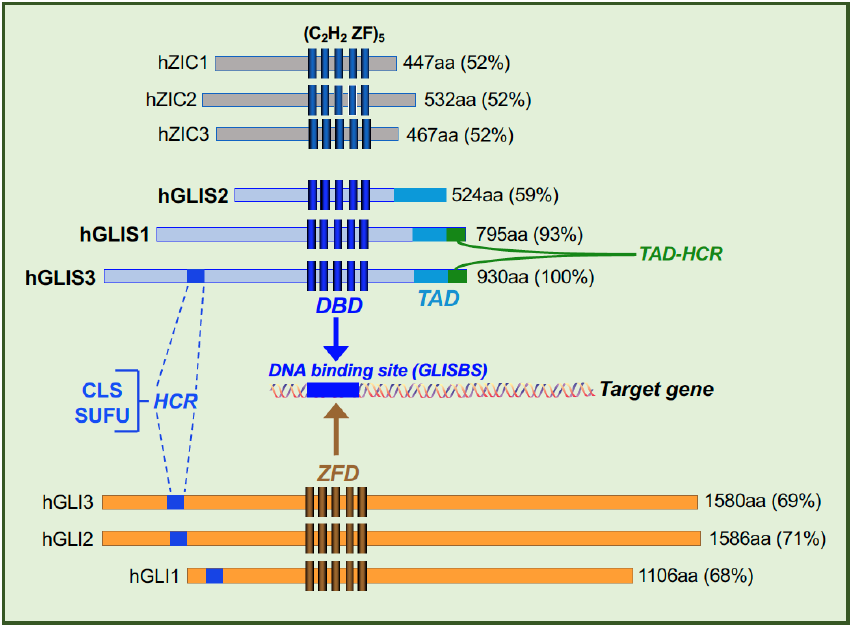
Figure 1. GLIS1-3 proteins are most closely related to members of the GLI subfamily Krüppel-like zinc finger transcription factors. The DNA binding domain (DBD) consists of five C 2 H 2 zinc fingers that exhibit high similarity with those of GLI1-3 and several ZIC family members. The DBD recognizes a GC-rich GLIS binding site (GLISBS) in regulatory region of target genes. Shown in parenthesis is the percent homology of each DBD relative to GLIS3-DBD. The transactivation domain (TAD) at the C-terminus of GLIS1 and GLIS3 contains a 32 amino acids sequence that is highly conserved (TAD-CR). The N-terminus of GLIS3 and GLI1-3 share a highly conserved region (HCR) of about 60 amino acids that contains a SUFU binding site and a ciliary localization signal (CLS) [6,15].